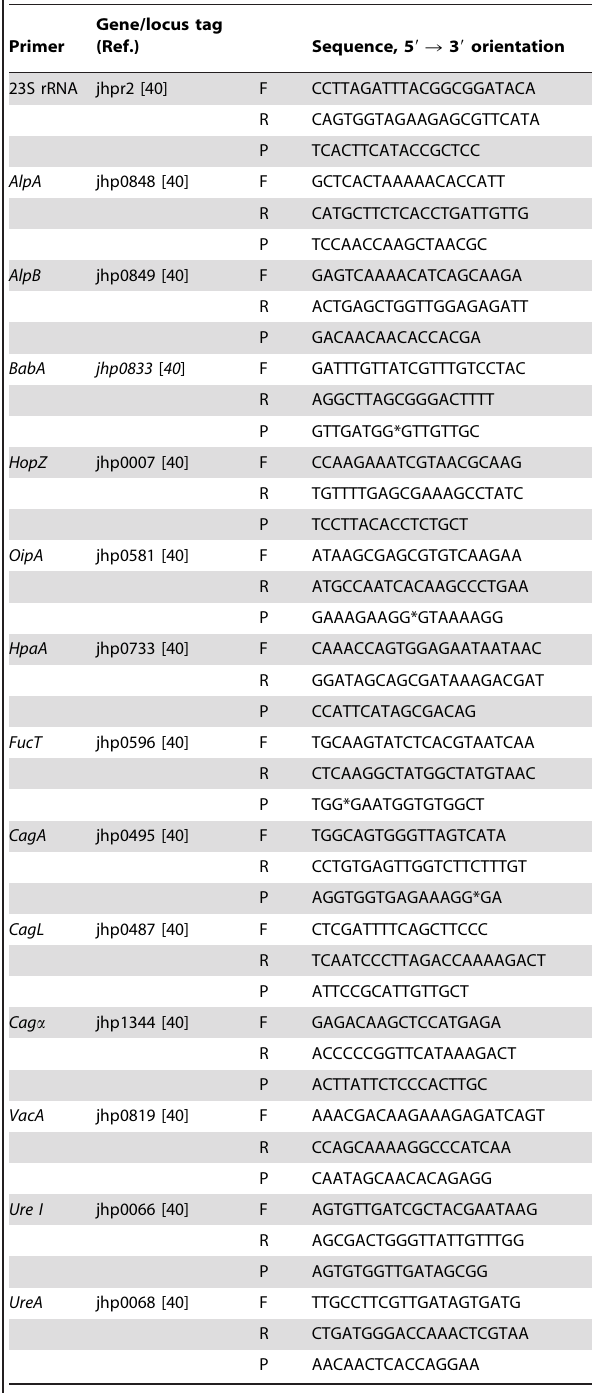
Table 1. Primer sequences for H. pylori (Qiagen).